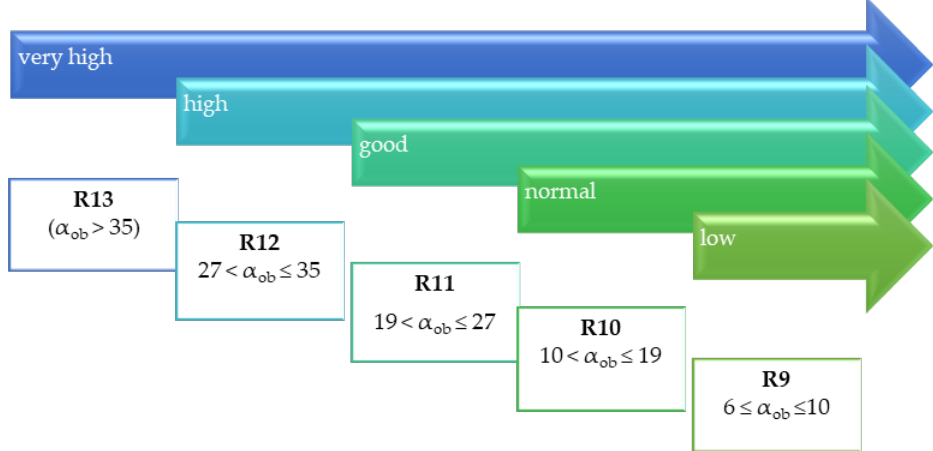
Figure 3. Slip resistance depending on the antislip class and the corresponding values of the acceptance angle ( α ob ) determined by the shoe foot method.